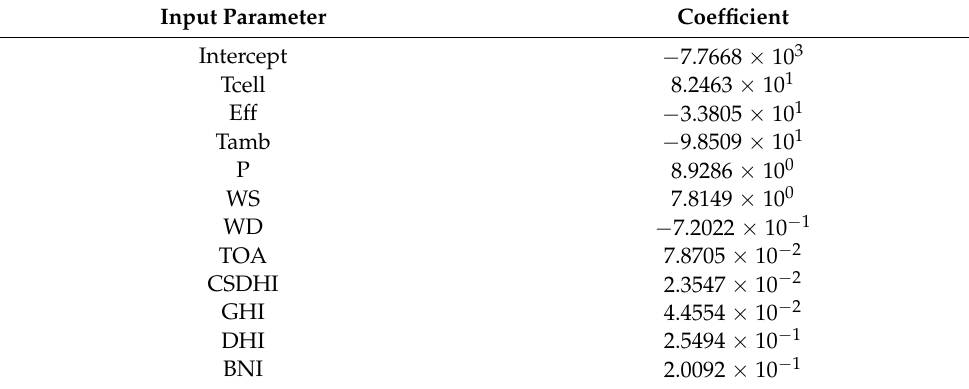
Table 6. Regression coefficients of the final